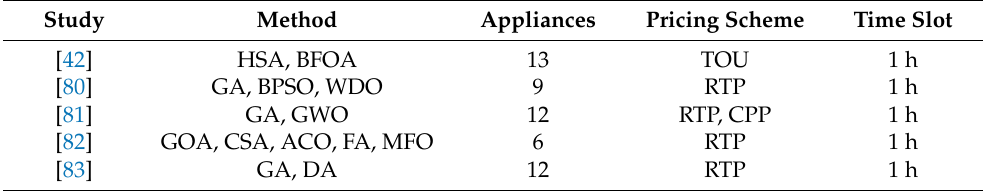
Table 11. Features of the compared studies. Time-of-use price (TOU)—two seasons.